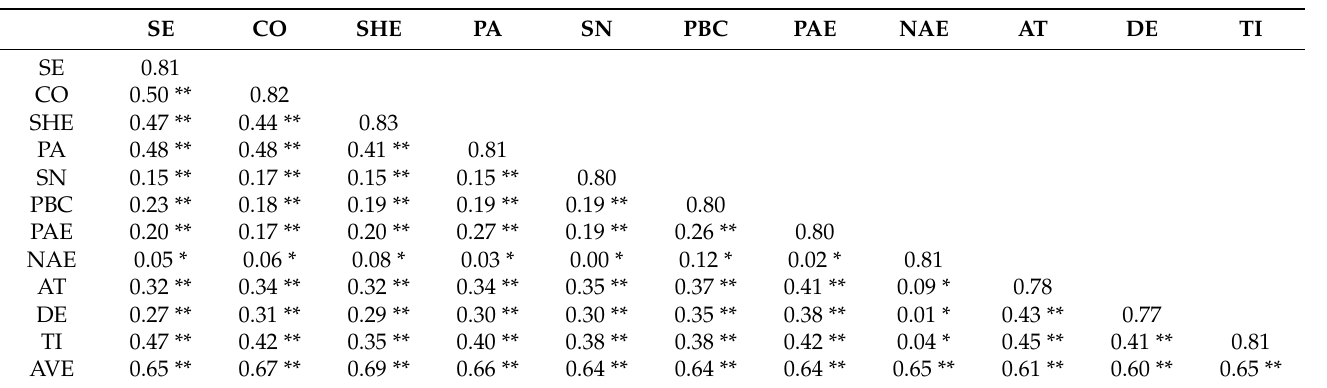
Table 2. Tests of discriminant